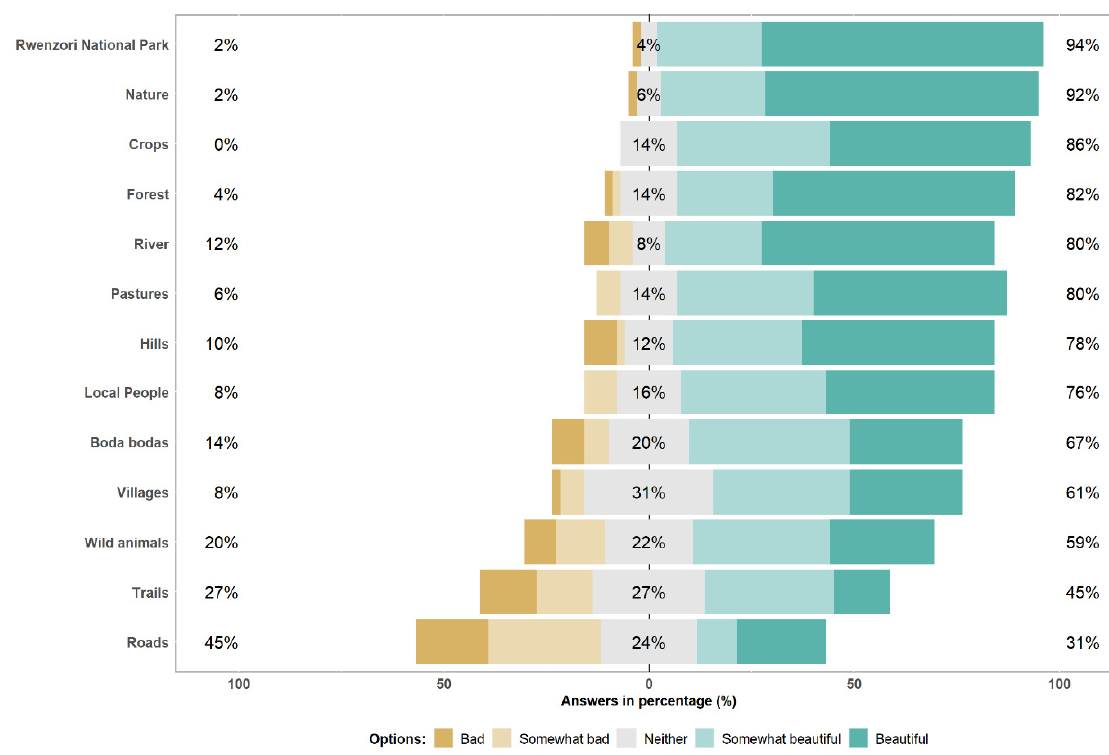
Figure 2. Elements and features of the Mubuku valley considered essential by inhabitants of Ruboni to describe their place of residence.